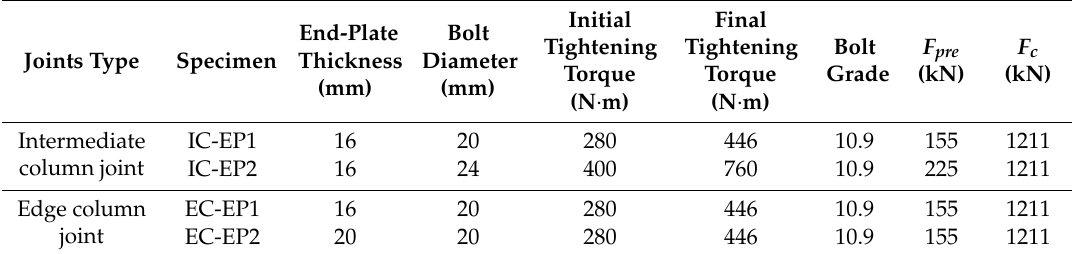
Table 1. Configuration details of joint